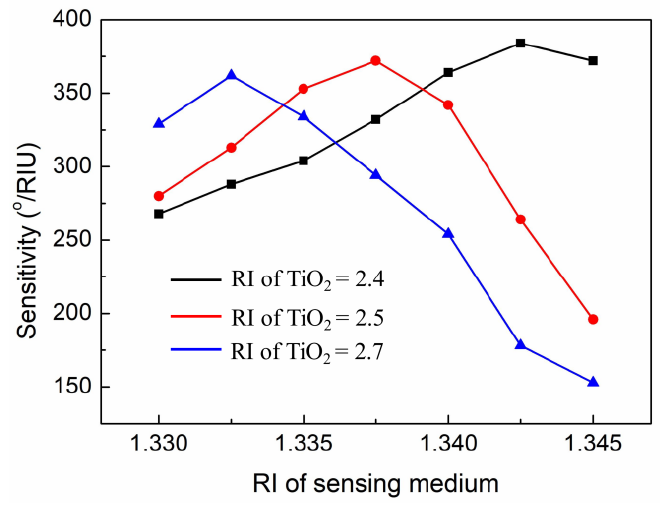
Figure 6. Change in sensitivity with respect to the different RIs of TiO 2 for the proposed sensor. Finally, we provide a table showing the performance comparisons between the pro- posed SPR sensor and other existing sensors in the literature. The sensitivity, metal type, and operating wavelength are considered in Table 2. The result shows that the sensitivity obtained here was much higher than all the previously proposed configurations. Table 2. The sensitivity, metal type, and operating wavelength for all sensor structures.